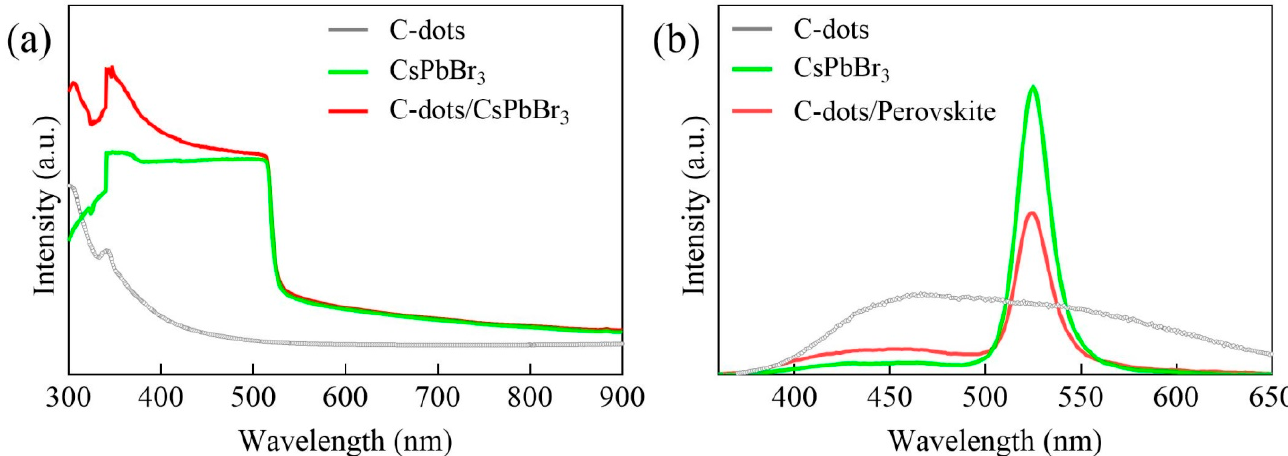
Figure 3. ( a ) Absorption spectra of C-dots, CsPbBr 3 perovskites, and C-dot/CsPbBr 3 perovskite bilayer structure films. ( b ) PL spectra of carbon nanodots, CsPbBr 3 perovskites, and carbon nanodot bilayer structure films.